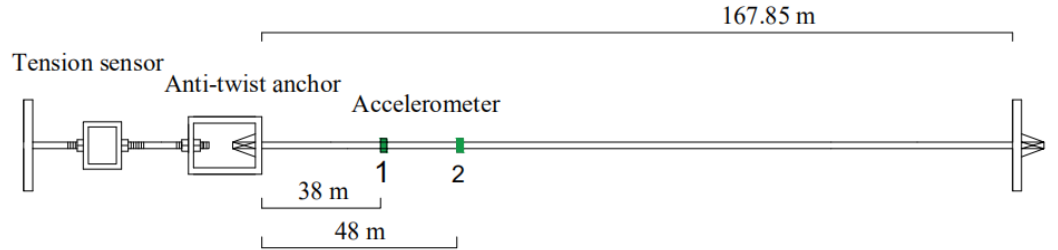
Figure 7. Design drawing of the stay cable in the full-scale model